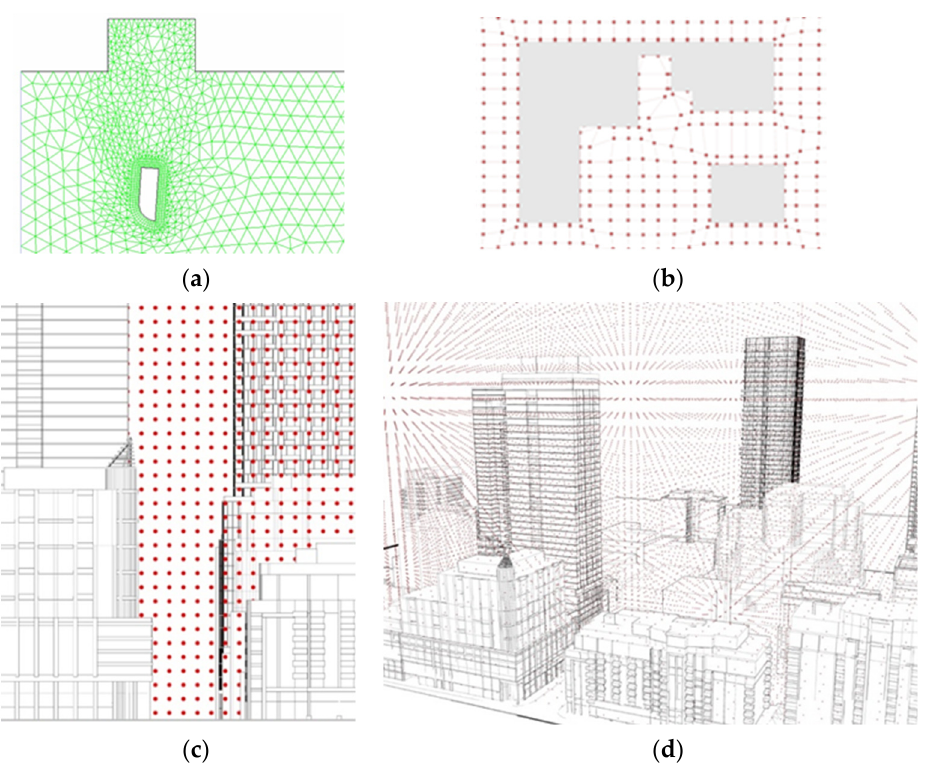
Figure 8. Cartesian discretization deployed in the study area. ( a ) CFD meshing; ( b ) Dynamic discretization; ( c ) Cross Sectional View; ( d ) 3D View.